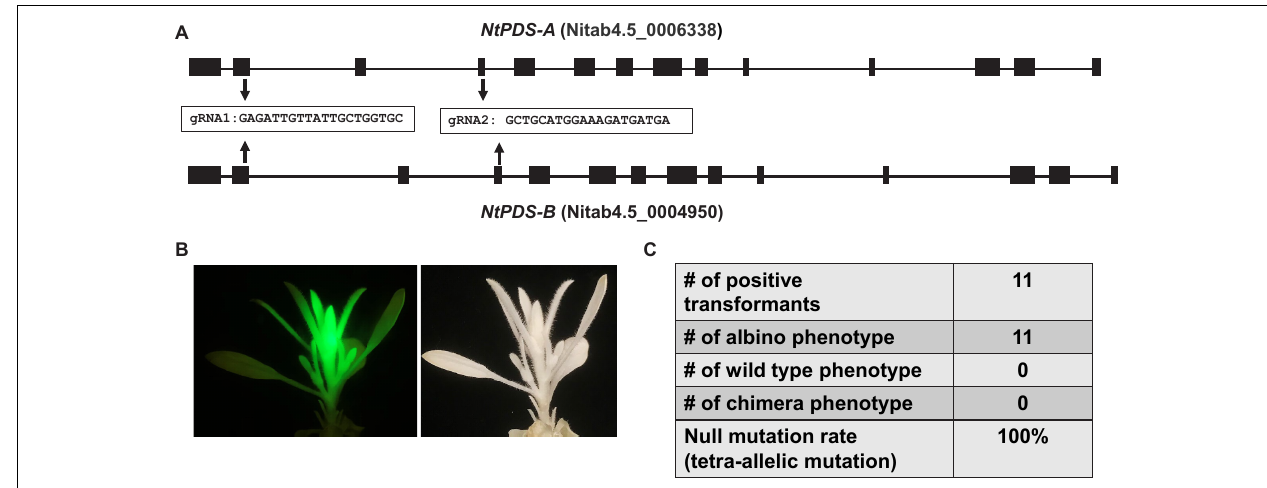
FIGURE 2 | The improved CRISPR/Cas9 system works efficiently for genome editing of tobacco ( Nicotiana tabacum ). (A) Gene structures of two NtPDS homologs from allotetraploid Nicotiana tabacum . Two gRNAs conserved in both NtPDS-A and NtPDS-B genes as indicated were designed for genome editing. (B) A representative picture shows the albino phenotype in genome modified Nicotiana tabacum . The construct contains GFP as visual marker. (C) Summary of editing efficacy.